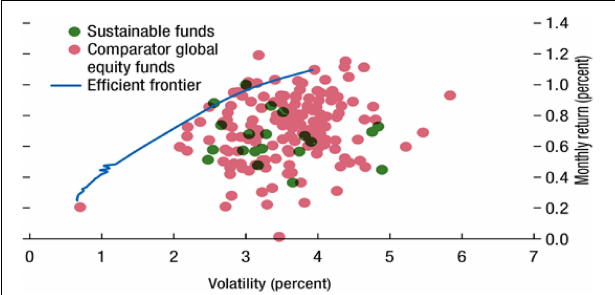
FIGURE 1 | Efficient frontier based on sustainable funds and comparator global equity funds. Source: IMF (Victor Hugo, 2019, p. 10), Global Financial Stability